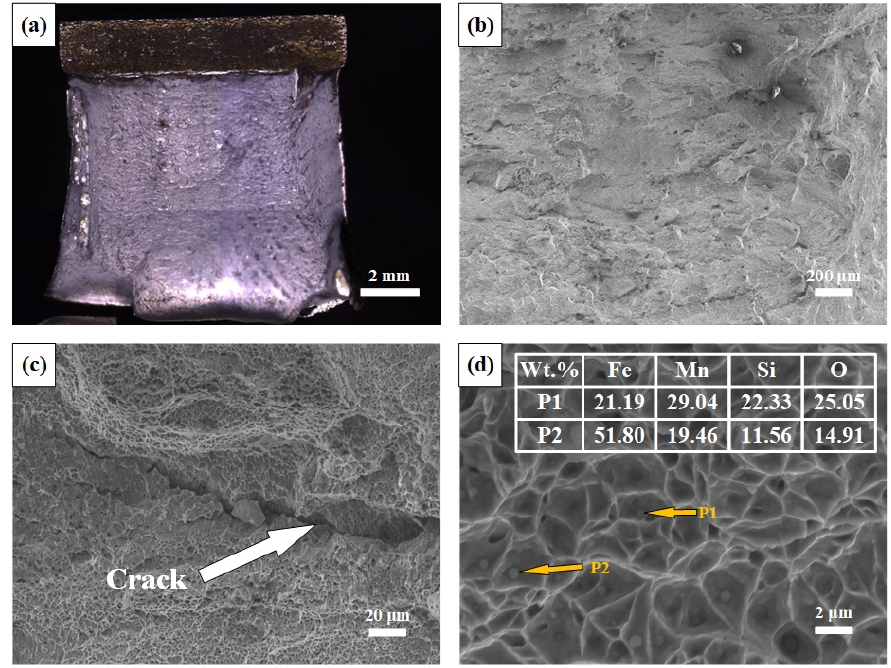
Figure 10. Charpy impact fracture of weld: ( a ) macrostructure; ( b – d ) SEM.